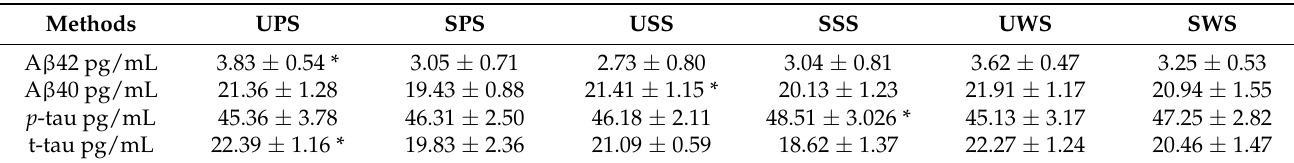
Table 1. Salivary A β 40, A β 42, t-tau, and p -tau levels of the studied